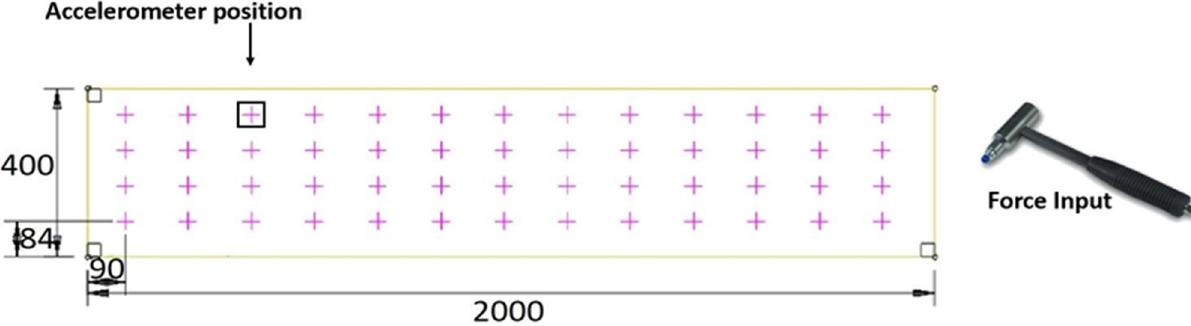
Figure 3. Modal analysis setup (dimensions in mm).